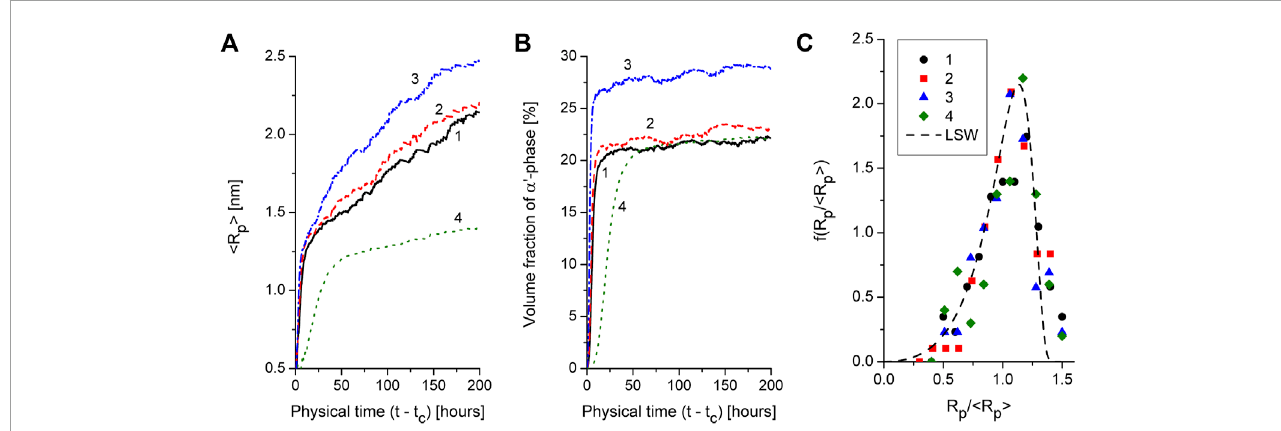
FIGURE 6 Protocols of the mean precipitate size (plot a) and volume fraction of α ′ -phase precipitates (plot b) at different content of Cr, Al and different temperatures: Line 1 — Fe-30%Cr-5%Al, T = 710 K , line 2 — Fe–30%Cr–7%Al, T = 710 K , line 3 — Fe–35%Cr–5%Al, T = 710 K , line 4 — Fe–30%Cr–5%Al, T = 690 K . Precipitate size distributions for different alloys and different temperatures (markers 1–4 relate to lines 1–4 in plots a and b) at coarsening stage ( t − t c = 200 h ) , dash line relates to LSW